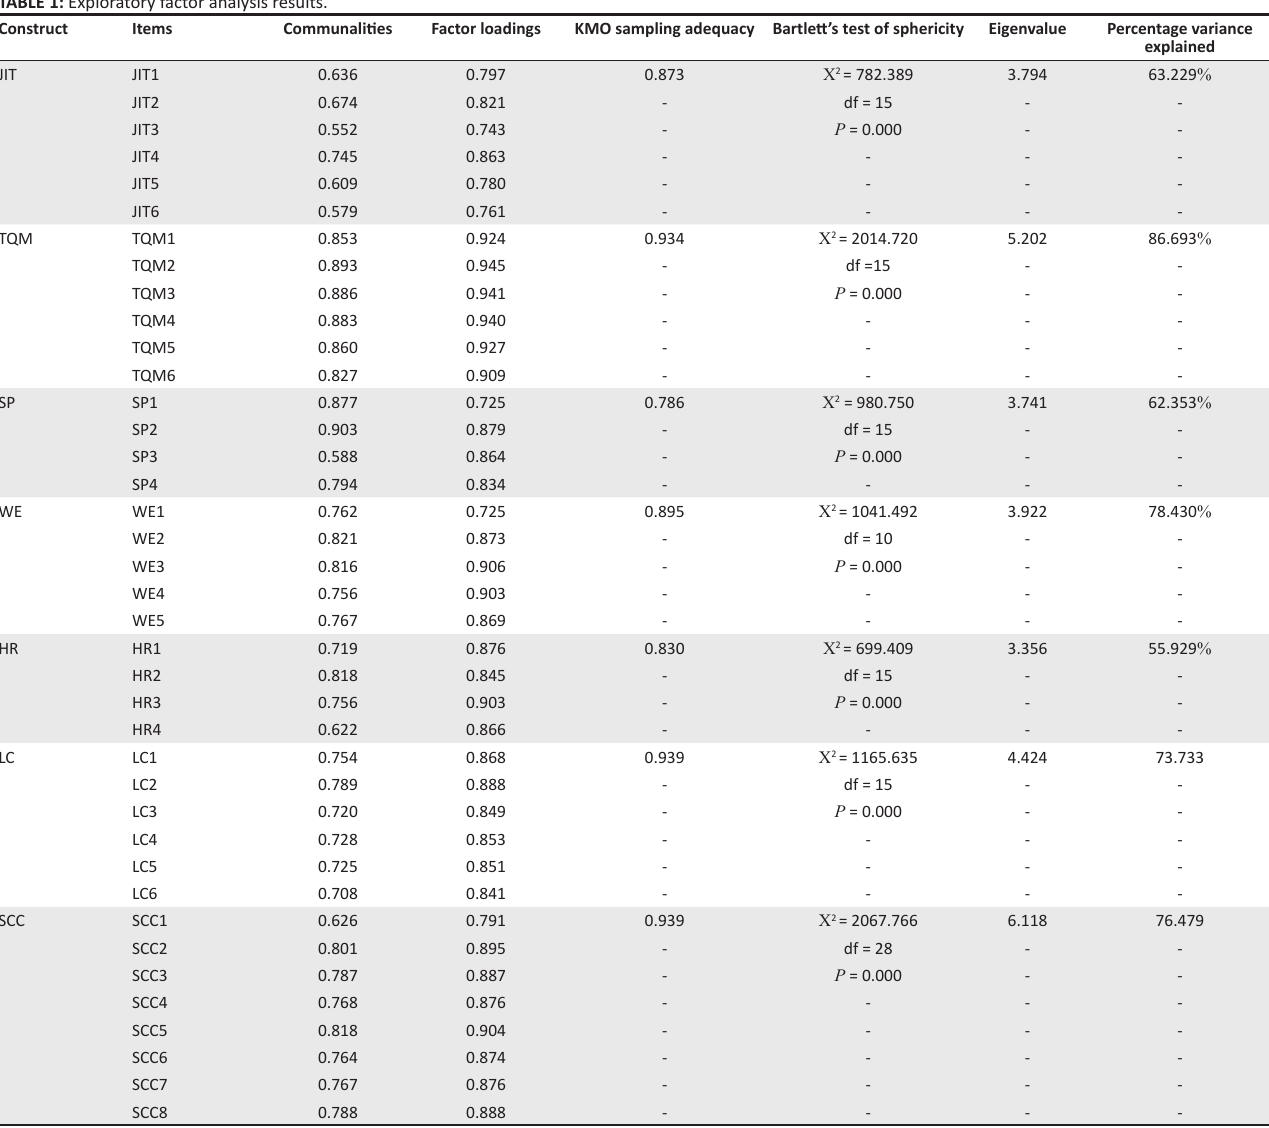
TABLE 1: Exploratory factor analysis results. Construct